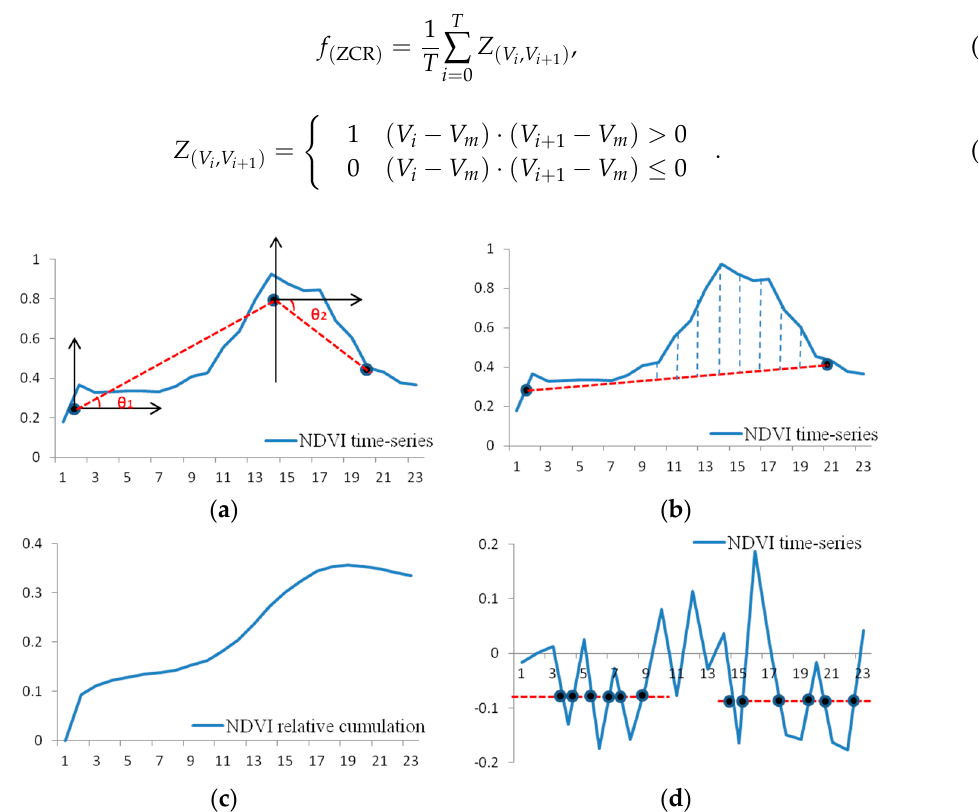
Figure 2. The shape parameters of the NDVI temporal curve. ( a ) θ 1 and θ 2 are phase angles of the NDVI temporal curve; ( b ) the red dotted line is the baseline of the NDVI time series; ( c ) the NDVI relative cumulative curve; ( d ) the zero-crossing rate in the start and end time periods, where the red dotted lines are the mean NDVI values during that period and the black dots denote the zero-crossing points in the baselines.